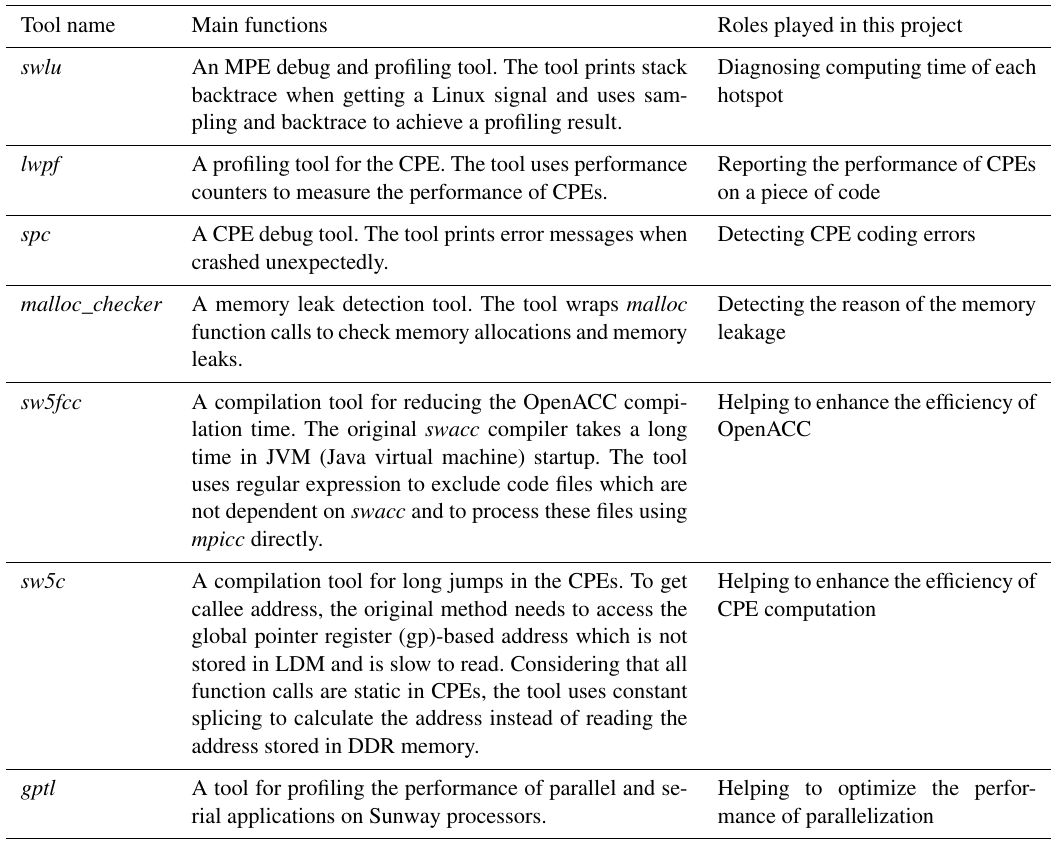
Table 1. The list of diagnostic software tools in the Sunway